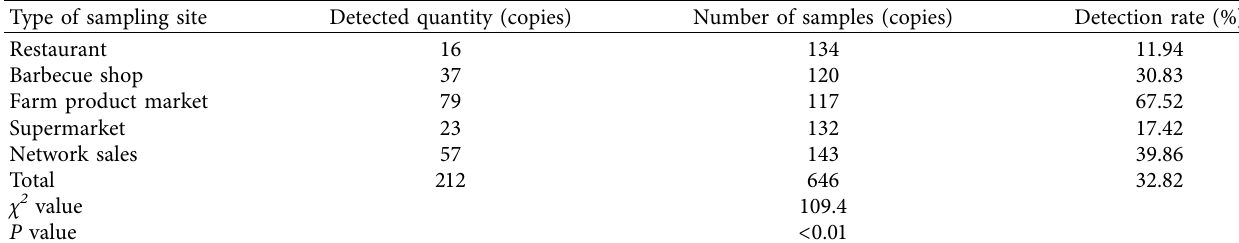
Table 7: Detection levels of pathogenic Vibrio in different sampling